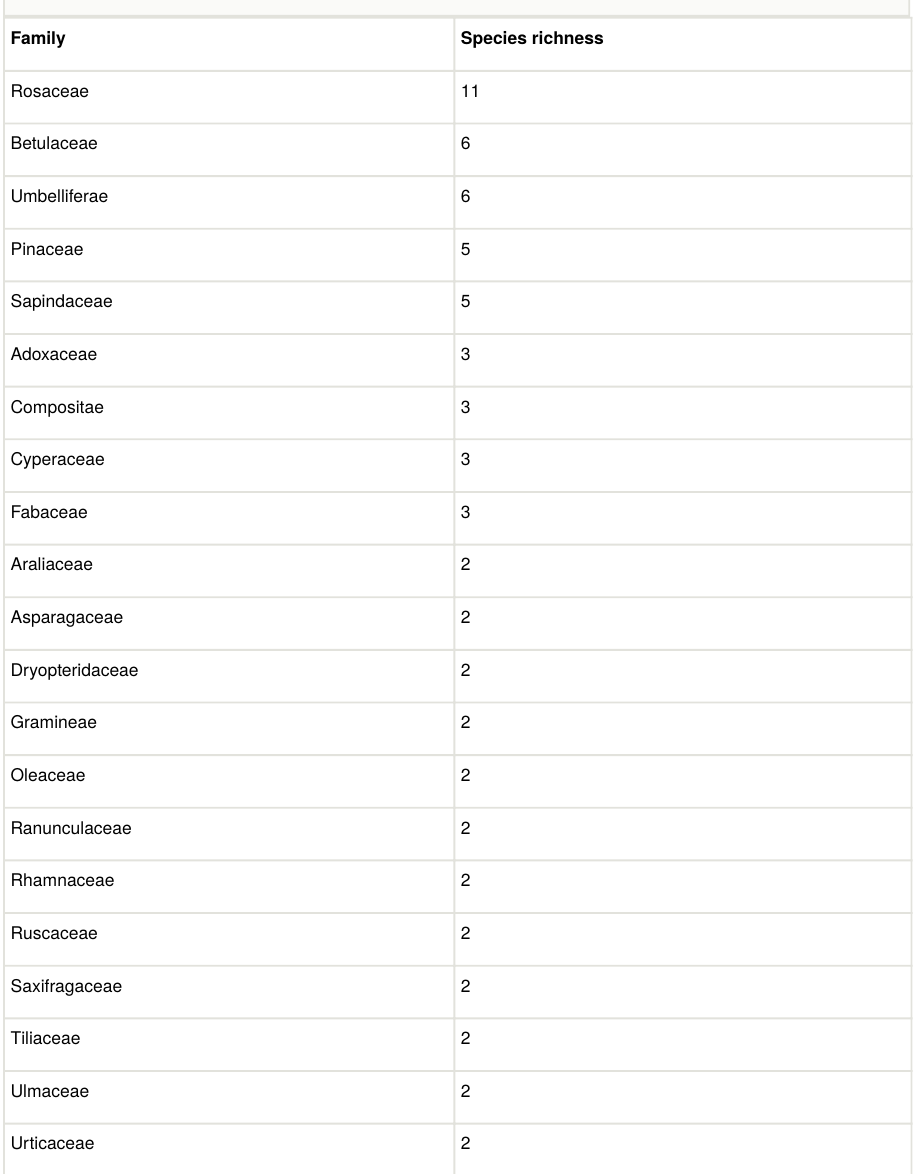
Table 3. The number of species in each family in Liangshui National Natural